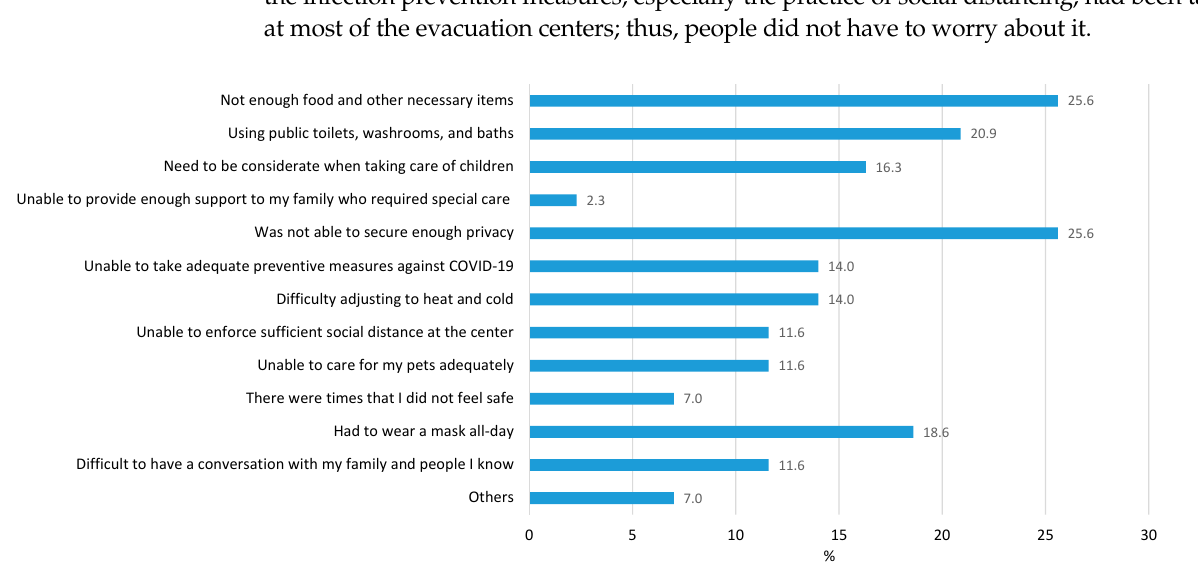
Figure 3. Major problems at the evacuation centers.